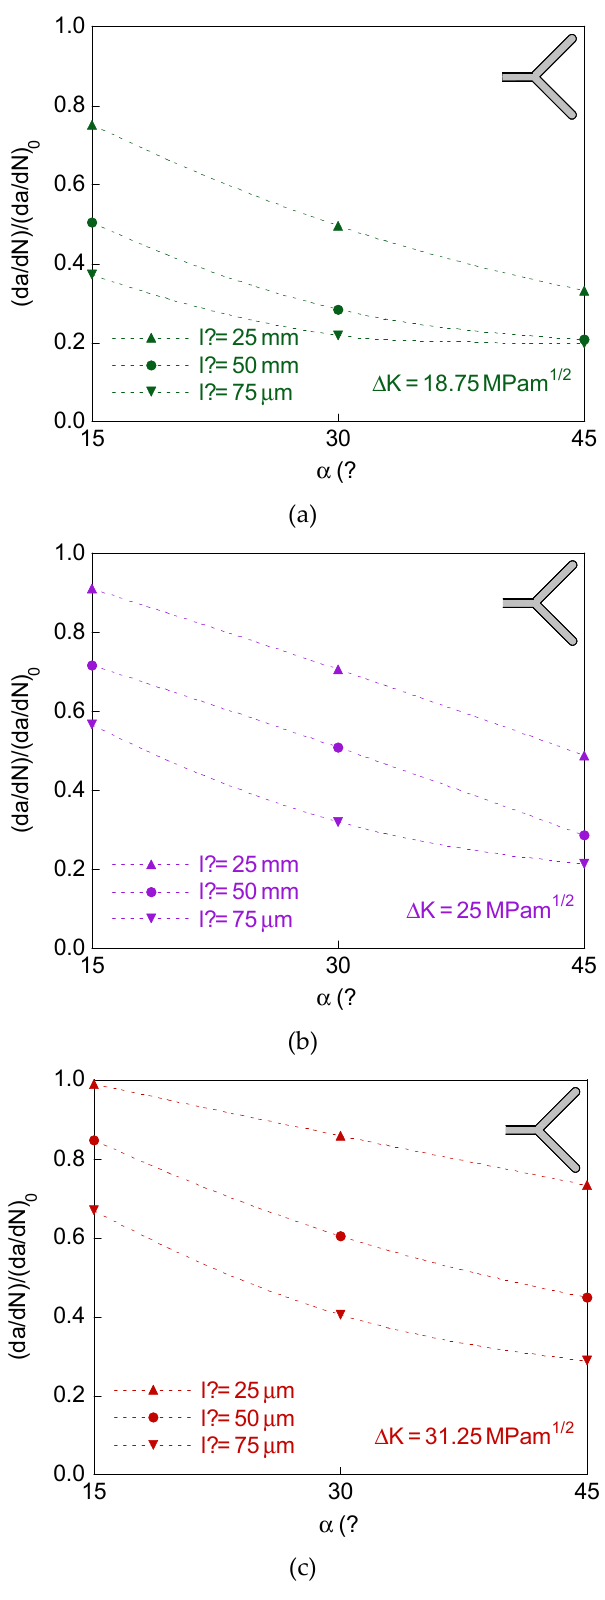
Figure 7. Retardation factor for the symmetric case (equal initial projected length and equal initial angle in the two branches): ( a ) Δ K = 18.75 MPam 1/2 ; ( b ) Δ K = 25 MPam 1/2 ; ( c ) Δ K = 31.25 MPam 1/2 .